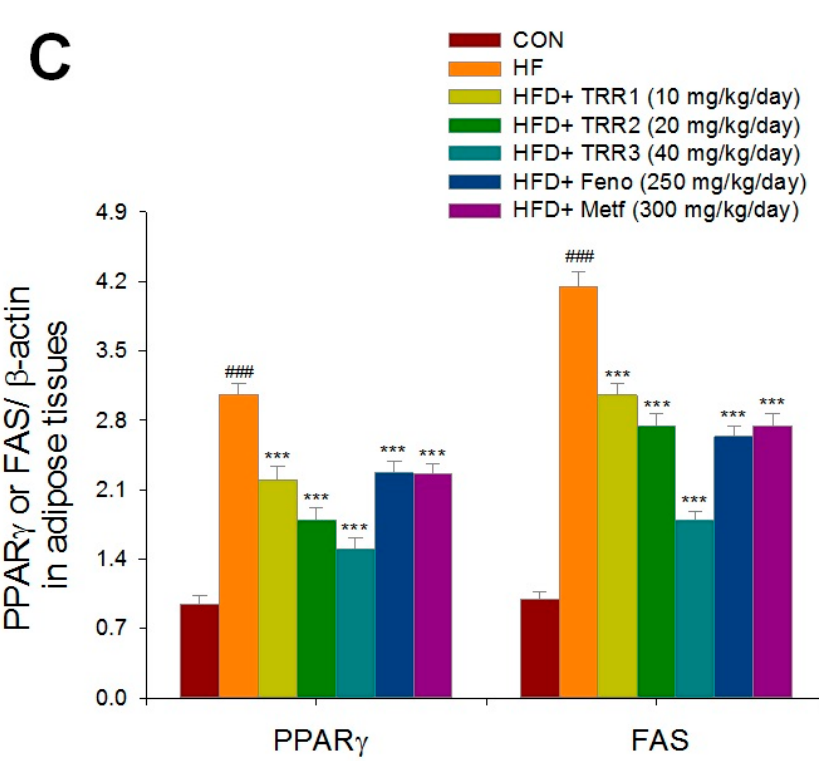
Figure 7. Expression levels of peroxisome proliferator-activated receptor α (PPAR α ), fatty acid synthase (FAS), and peroxisome proliferator-activated receptor γ (PPAR γ ) in the liver, and PPAR γ and FAS in adipose tissue of mice by oral gavage eburicoic acid (TRR). ( A ) Representative images including PPAR α , FAS, and PPAR γ in different tissues. ( B , C ) Quantification of the expression levels of PPAR α , FAS, and PPAR γ in the liver and expression levels of FAS and PPAR γ in adipose tissue. Protein was separated by 12% SDS–PAGE detected by Western blot. All values are means ± SE ( n = 9). # p < 0.05 and ### p < 0.001 compared with the control (CON) group; * p < 0.05 and *** p < 0.001 compared with the HFD plus vehicle (distilled water) (HF) group using ANOVA and with Dunnett’s tests. TRR1, TRR2, or TRR3: 10, 20, or 40 mg/kg body weight eburicoic acid, respectively; Feno: Fenofibrate (250 mg/kg body weight); Metf: Metformin (300 mg/kg body weight).